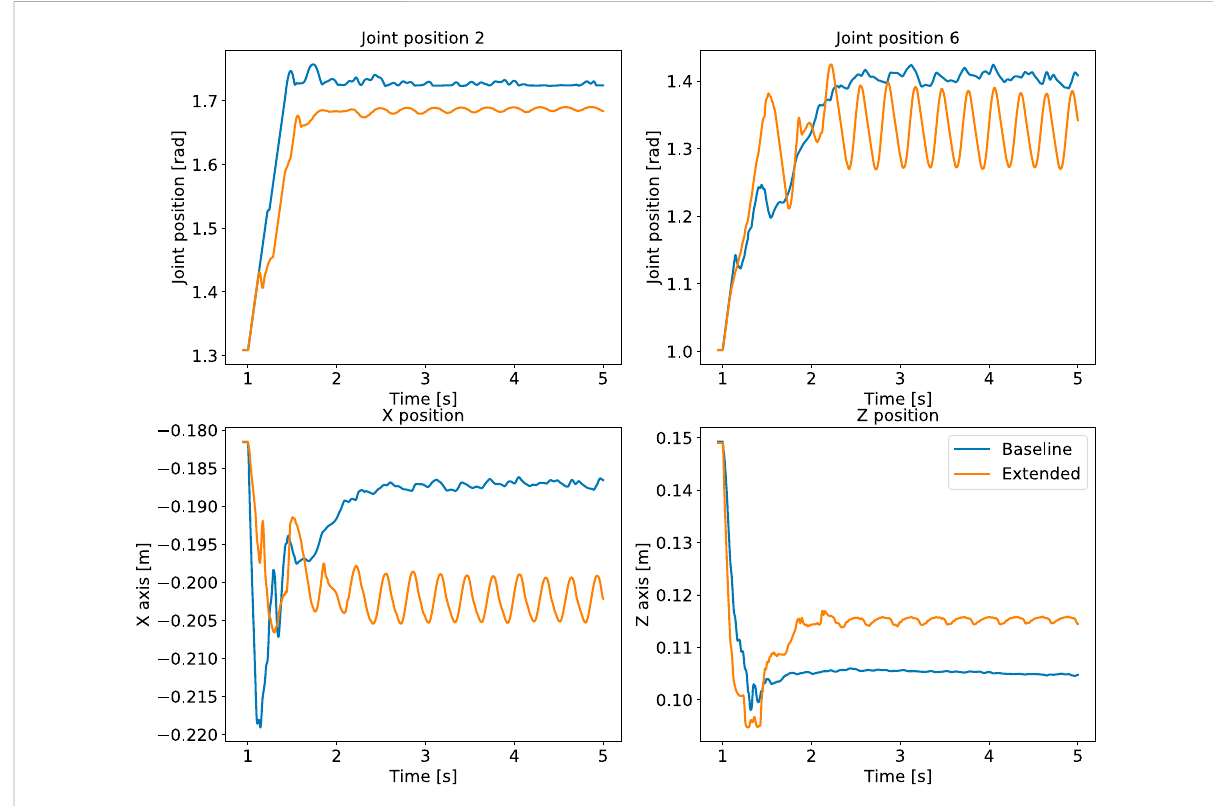
FIGURE 9 Manipulation performance: comparison of policies trained using the optimal baseline state space versus the extended states for. Oscillatory behaviour using the extended state space (orange), compared to our formulated baseline policy